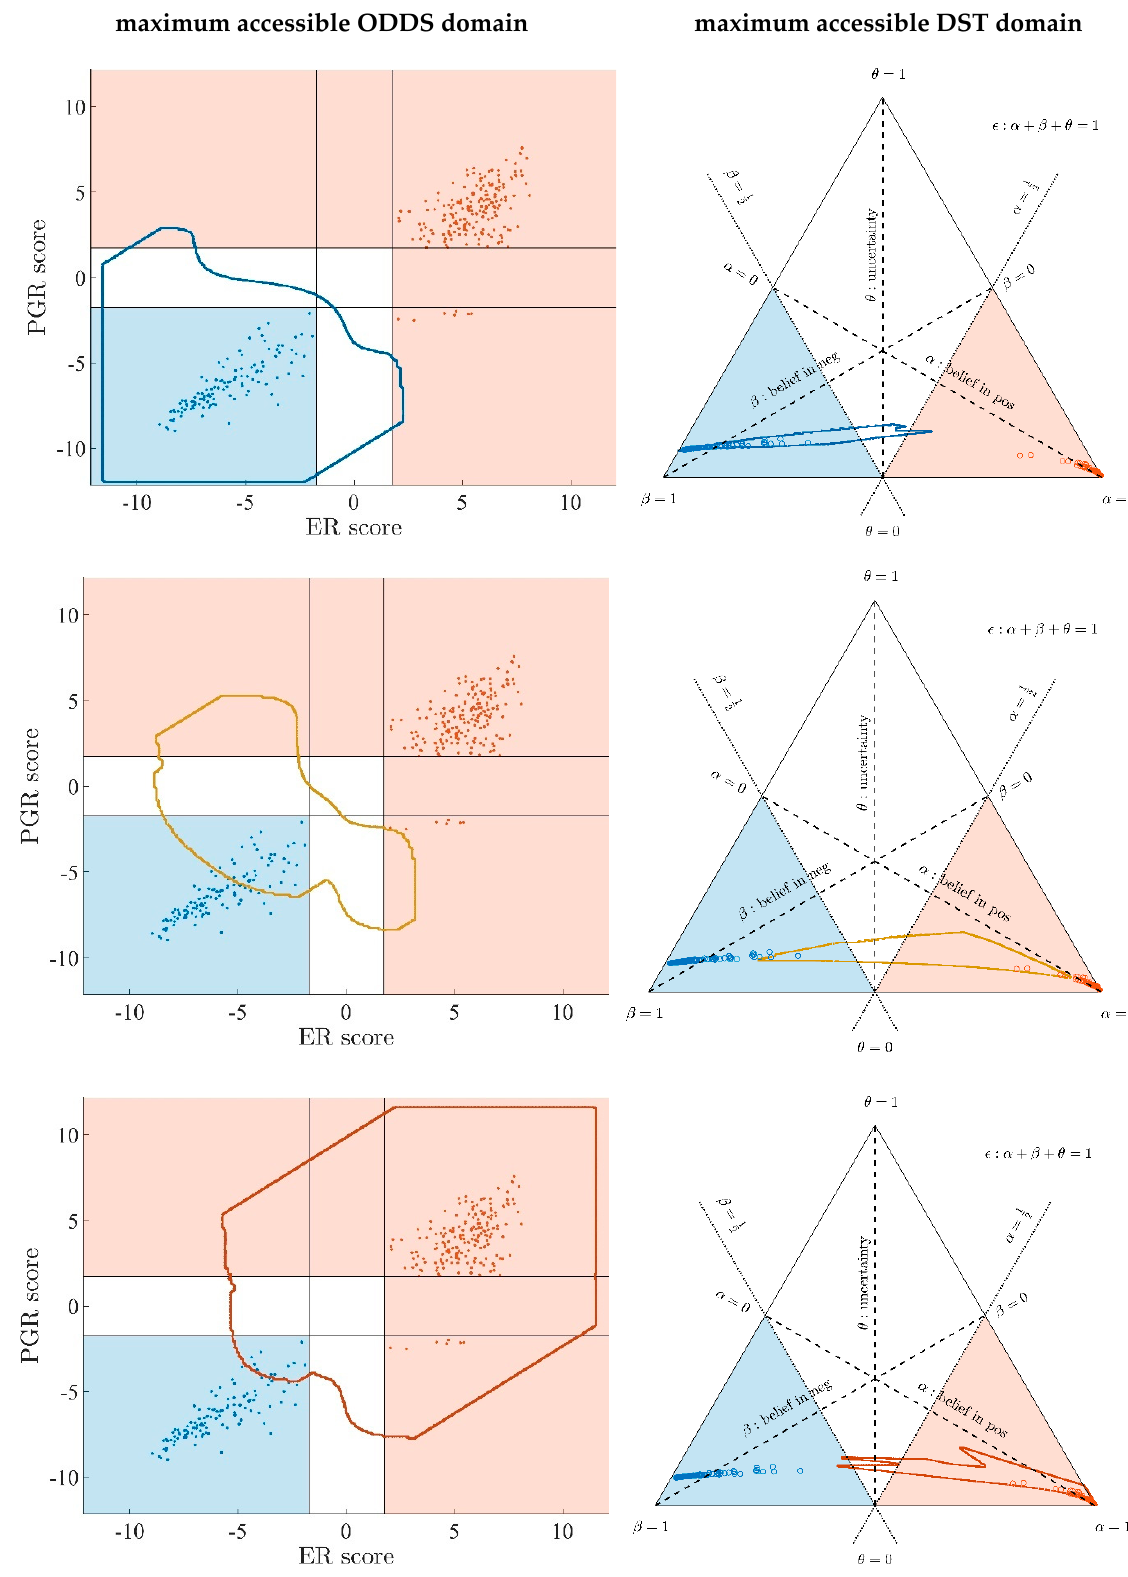
Figure A6. Real sample data within maximum accessible domains for totally unknown IHC = (0,0). For general features of display see caption to Figure A3.